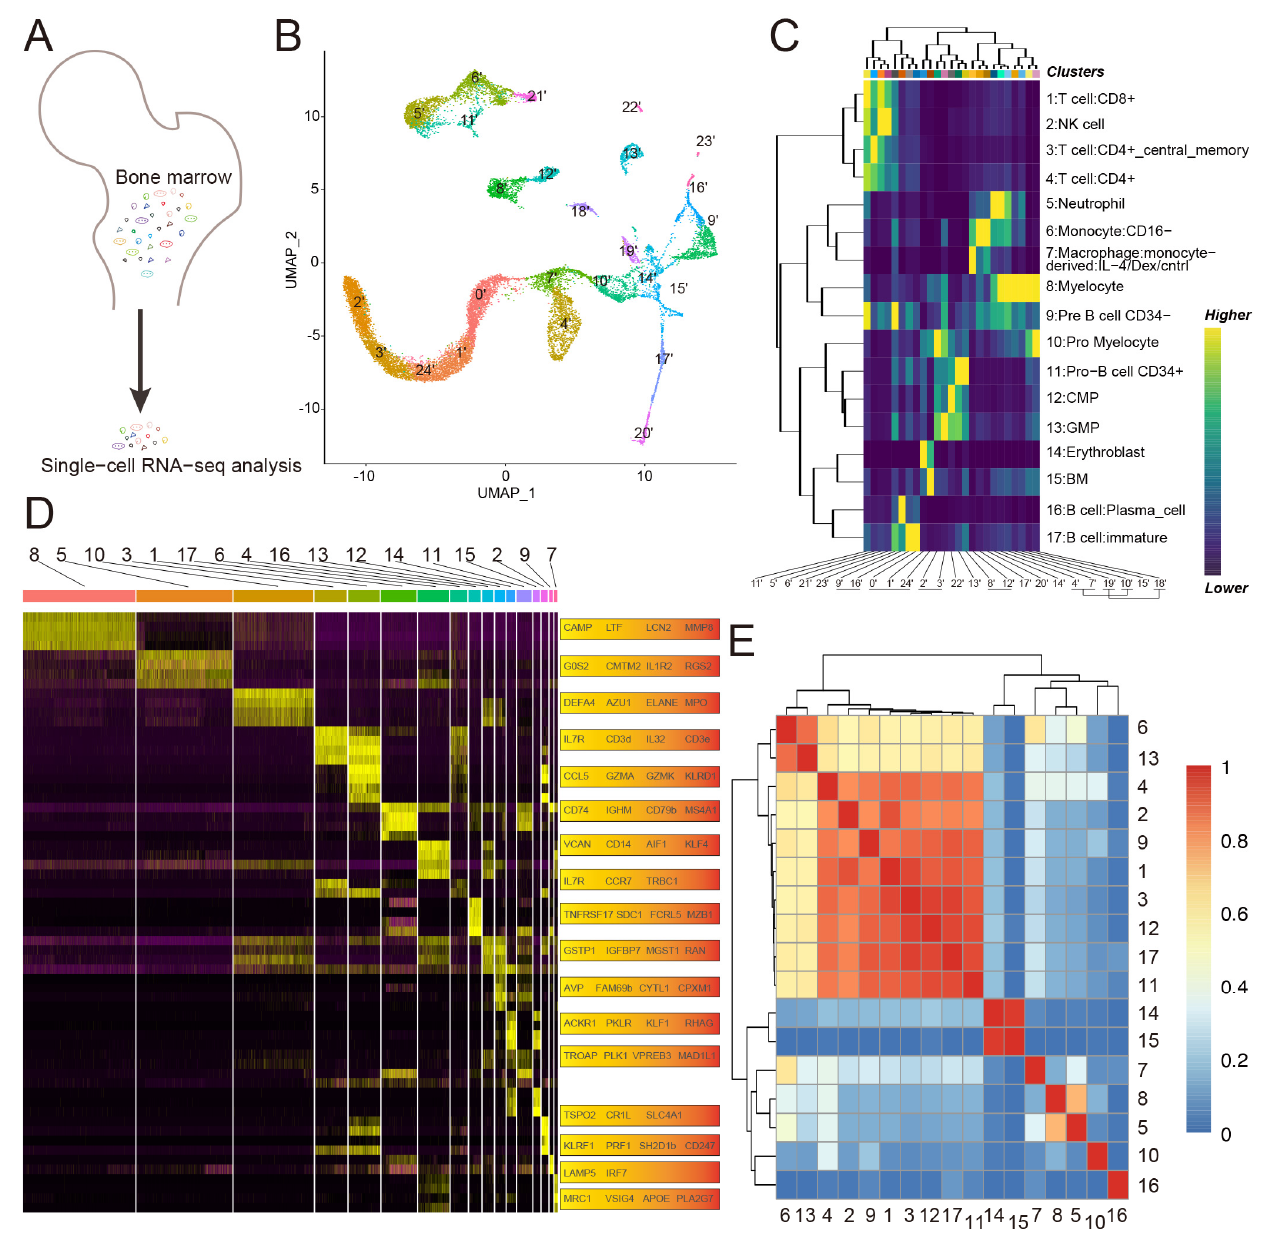
Figure 1. Single − cell RNA-seq of human bone marrows . Bone marrow extracted and droplet-based single-cell RNA-seq after rigorous filtration ( A ). Cellular composition of human bone marrow using uniform manifold approximation and projection ( B ). Seventeen cell types formed by 25 clusters ( C ). Seventeen cell types identified by 2 to 4 marker genes ( D ). The correlations of average expression profiles among cell types ( E ).